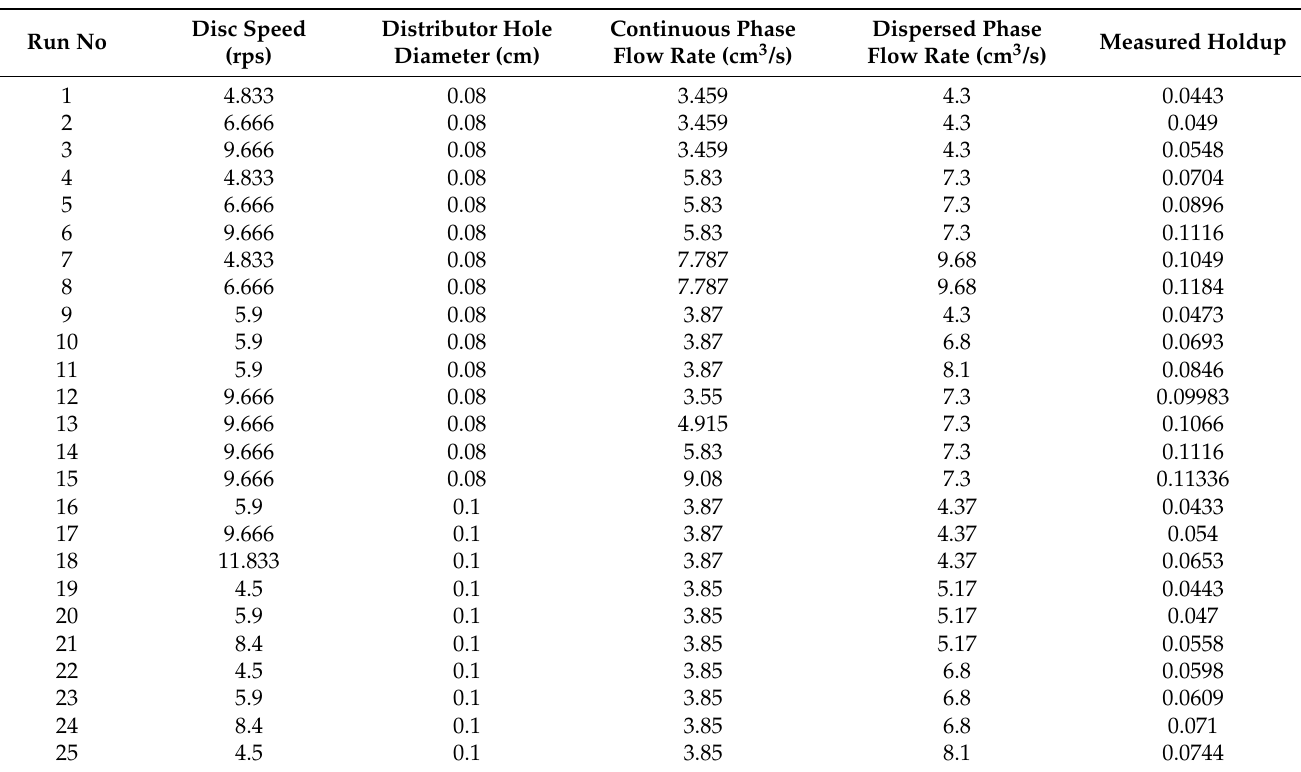
Table A1. Toluene was dispersed into water to prevent the adhesion of large or small drops dispersed in the aqueous phase. A sample of the data is provided in Appendix